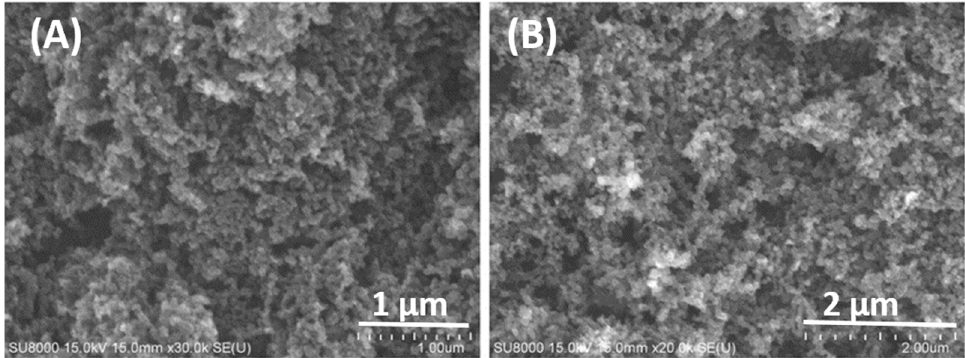
Figure 1. SEM image of ( A ) KB and ( B ) Super P conductivity enhancement additives.